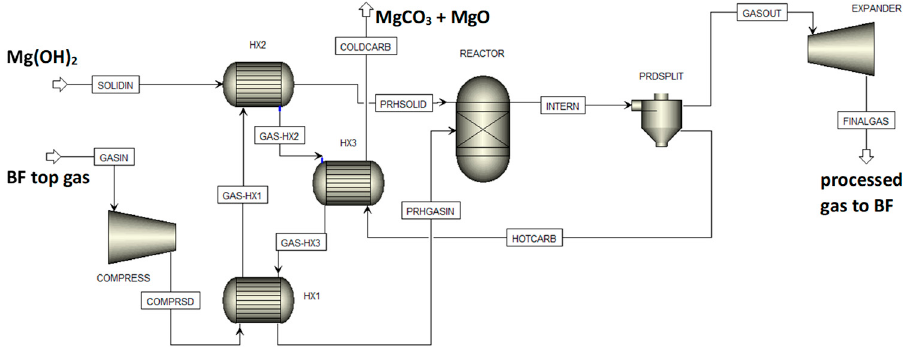
Figure 13. The Aspen Plus flow sheet for BF top gas processing.